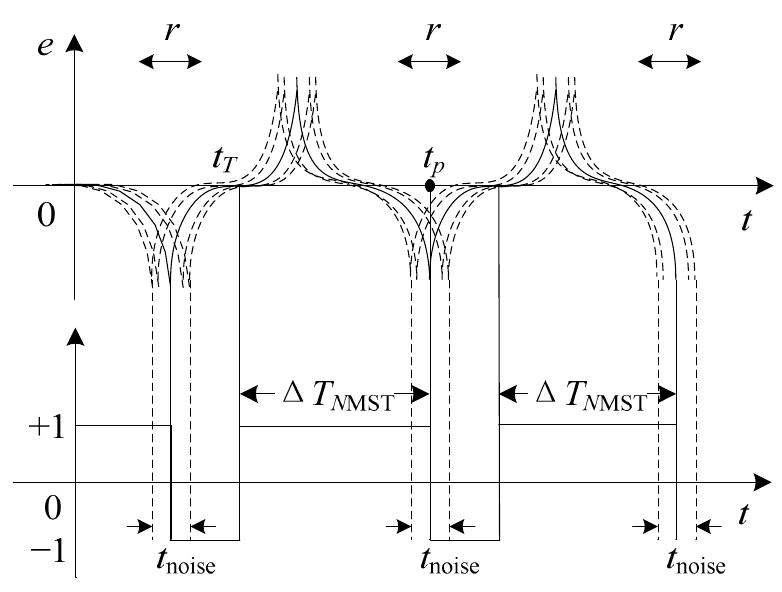
Figure 7. Noise effects in the NMST readout scheme.